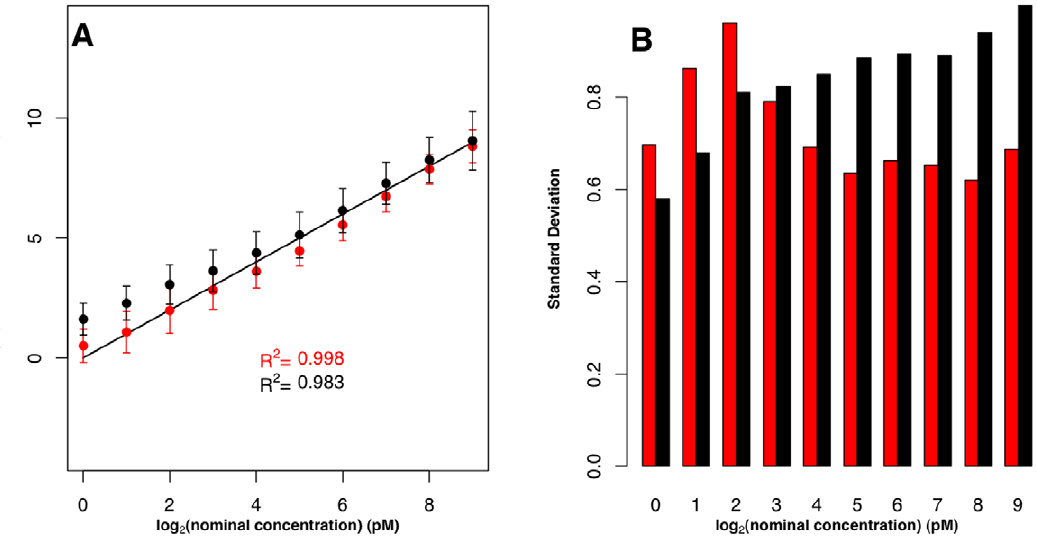
Figure 1. Estimation of transcript concentrations on the Affymetrix platform: Comparison to hybridization model-based approach. Estimations of 19 transcripts chosen by Li et al. ( A ) Results obtained from a training set of three probesets for GLAM (red) and those obtained from Li et al. approach (black). Error bars are standard deviations. The solid line is the identity line ( x = y ). ( B ) Comparison of error bar lengths for each concentration for our approach (red) and the Li et al. approach